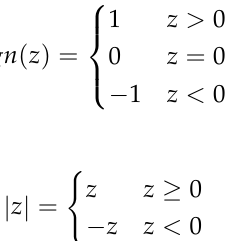
Figure 1. Three-pond hydraulic